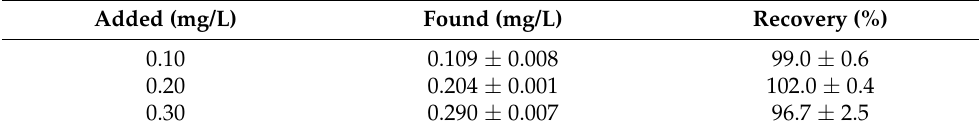
Table 3. Results for the recovery study in a real water